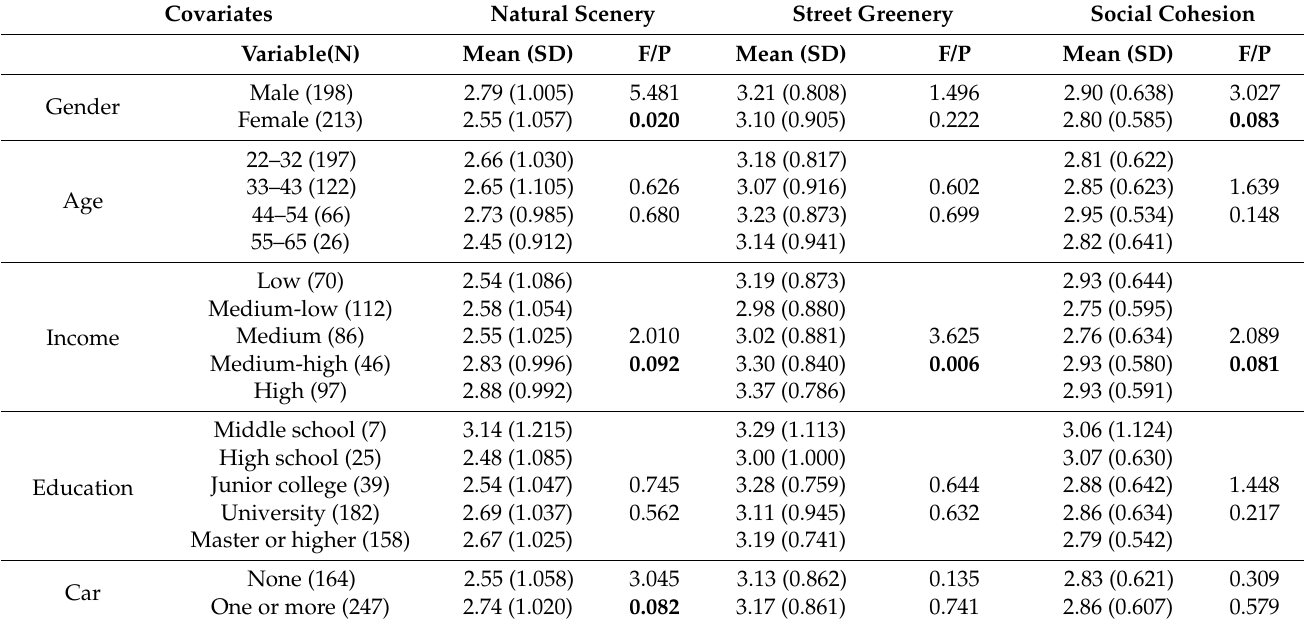
Table A1. Sociodemographic associations with perceived green space and social cohesion.